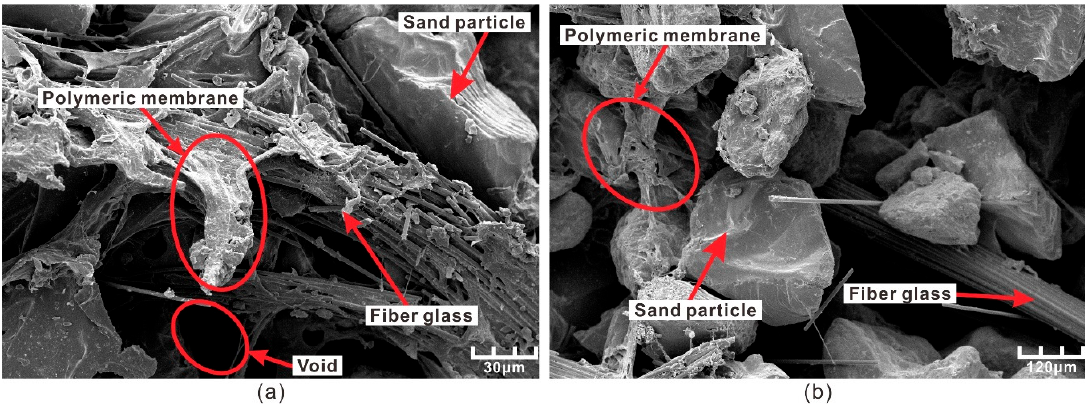
Figure 18. Scanning electron microscopy (SEM) micrograph of fiber-sand mixture: ( a )